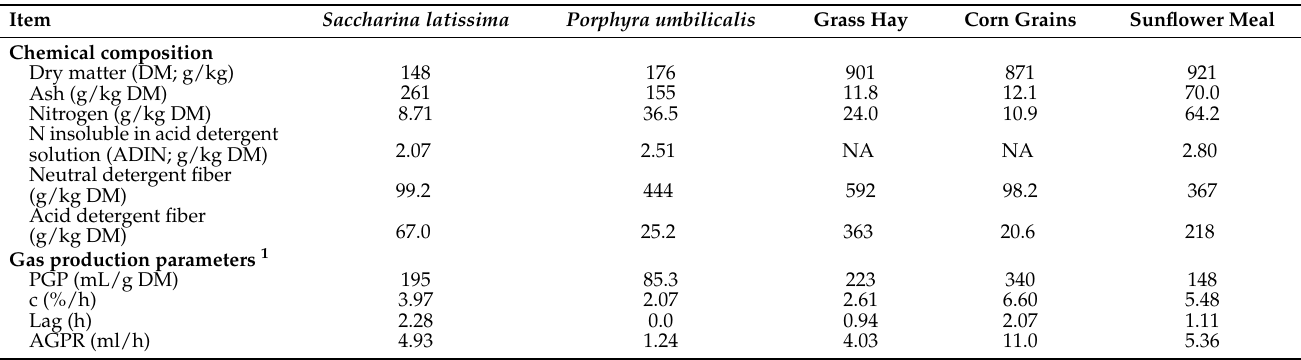
Table 2. Chemical composition and in vitro gas production parameters of the samples of Saccharina latissima and Porphyra umbilicalis and of samples of grass hay, corn grains and sunflower meal used as reference